Question: Summarize what this figure shows in one sentence.
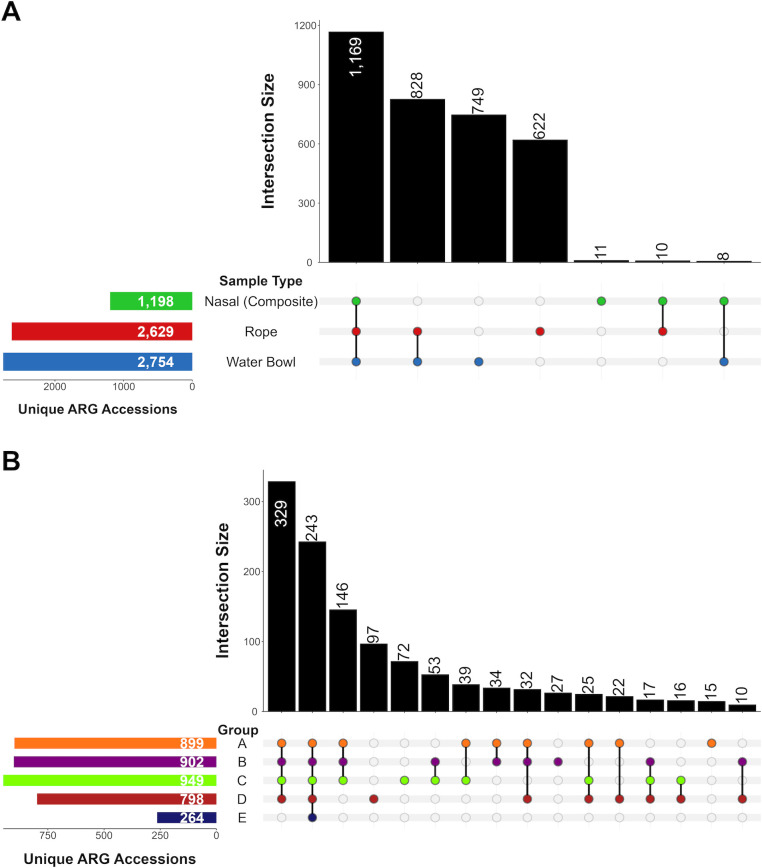
Answer: Intersection of ARGs detected across sample types and cattle groups. UpSet plots show intersections of detected ARG accessions across ( A ) sample types (nasal, rope, and water bowl) and ( B ) groups (stratified on nasal samples only). The set size bar plots (left) represent the total number of unique ARGs detected within each category, while the intersection size bar plots (top) indicate the number of ARGs shared among different category combinations. Connected black dots at the bottom identify which sample types or groups are included in each intersection. Intersections involving fewer than 10 ARGs and ARGs without intersections are not displayed.